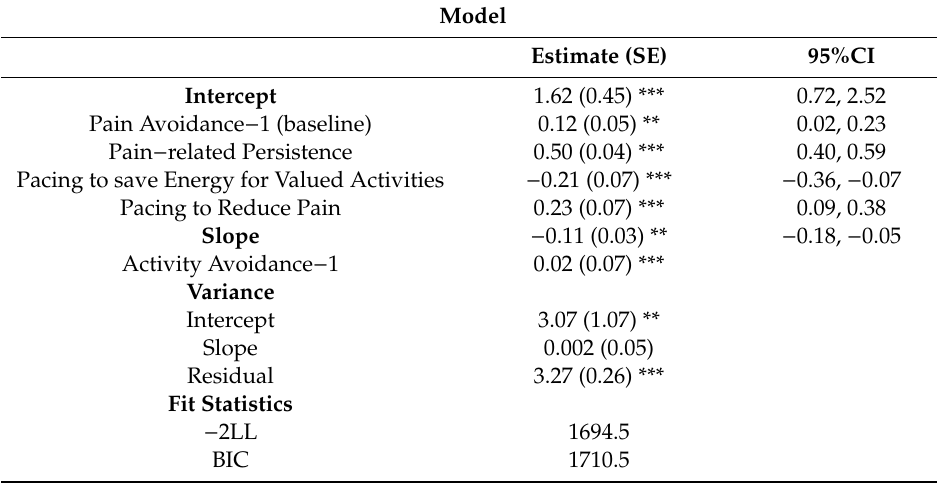
Table 2. Significant parameter estimates and fit indexes for the linear mixed